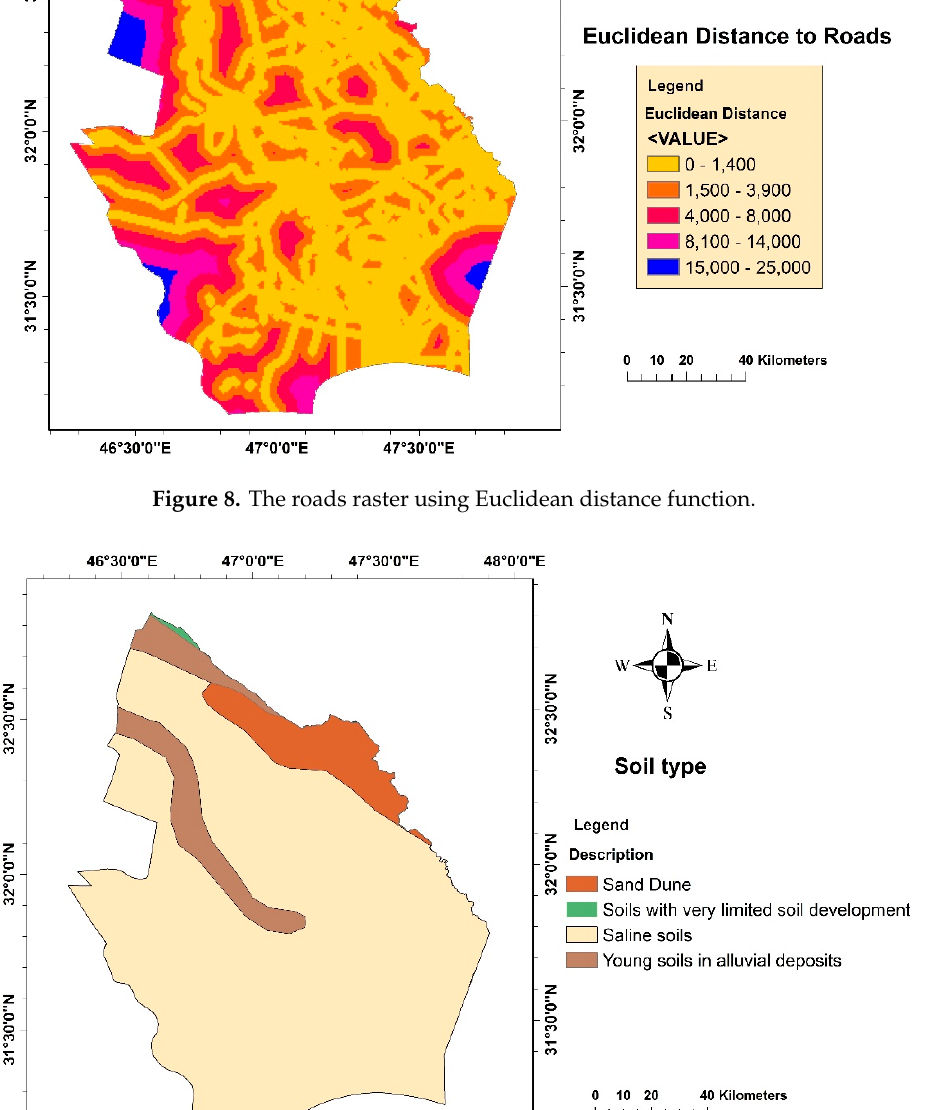
Figure 9. Food and Agriculture Organization (FAO) soil map.